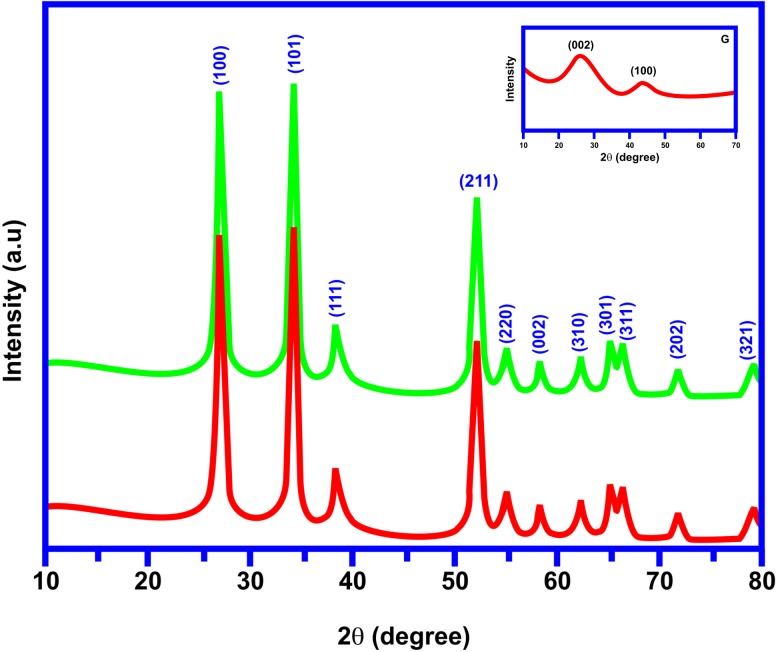
X-ray diffraction pattern of SnO2/G nanocomposite.